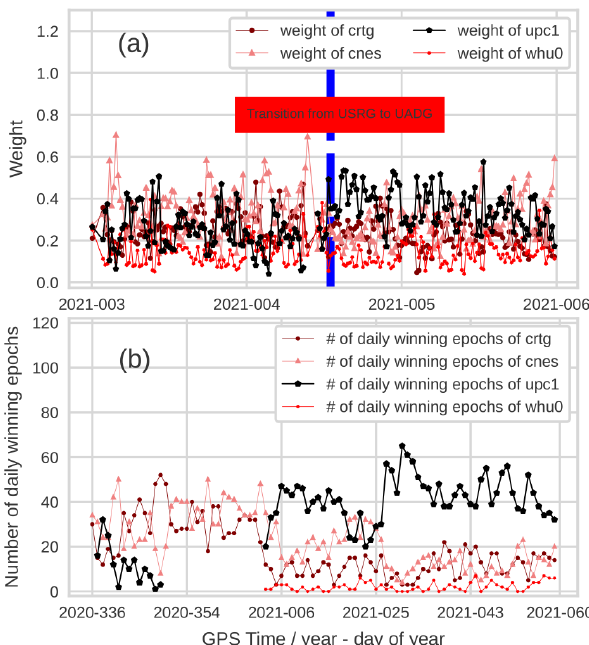
Figure 5. The evolution of real-time weights and daily winning epochs of RT-GIMs. (a) The real-time weights from 3 to 5 Jan- uary 2021. (b) The daily number of epochs when one of the RT-GIMs is better than the others from 1 December 2020 to 1 March